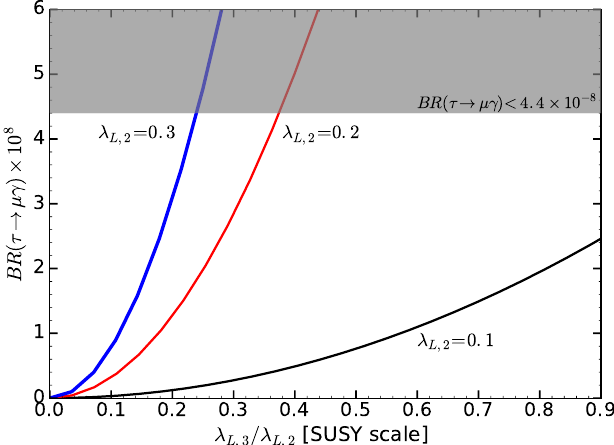
Figure 10. BR( (cid:28) (cid:22)(cid:13) ) 10 8 as function of the ratio (cid:21) L; 3 =(cid:21) L; 2 at the SUSY scale in the LD ! (cid:2) model. From top to bottom, the lines correspond to (cid:21) L; 2 0 : 3, 0.2, and 0.1 (which leads to (cid:25) (cid:14) ( g 2) = 12 10 (cid:0) 10 ; 18 10 (cid:0) 10 , and 27 10 (cid:0) 10 ). All other parameters are (cid:12)xed as in the (cid:22) (cid:0) (cid:2) (cid:2) (cid:2) benchmark point in table